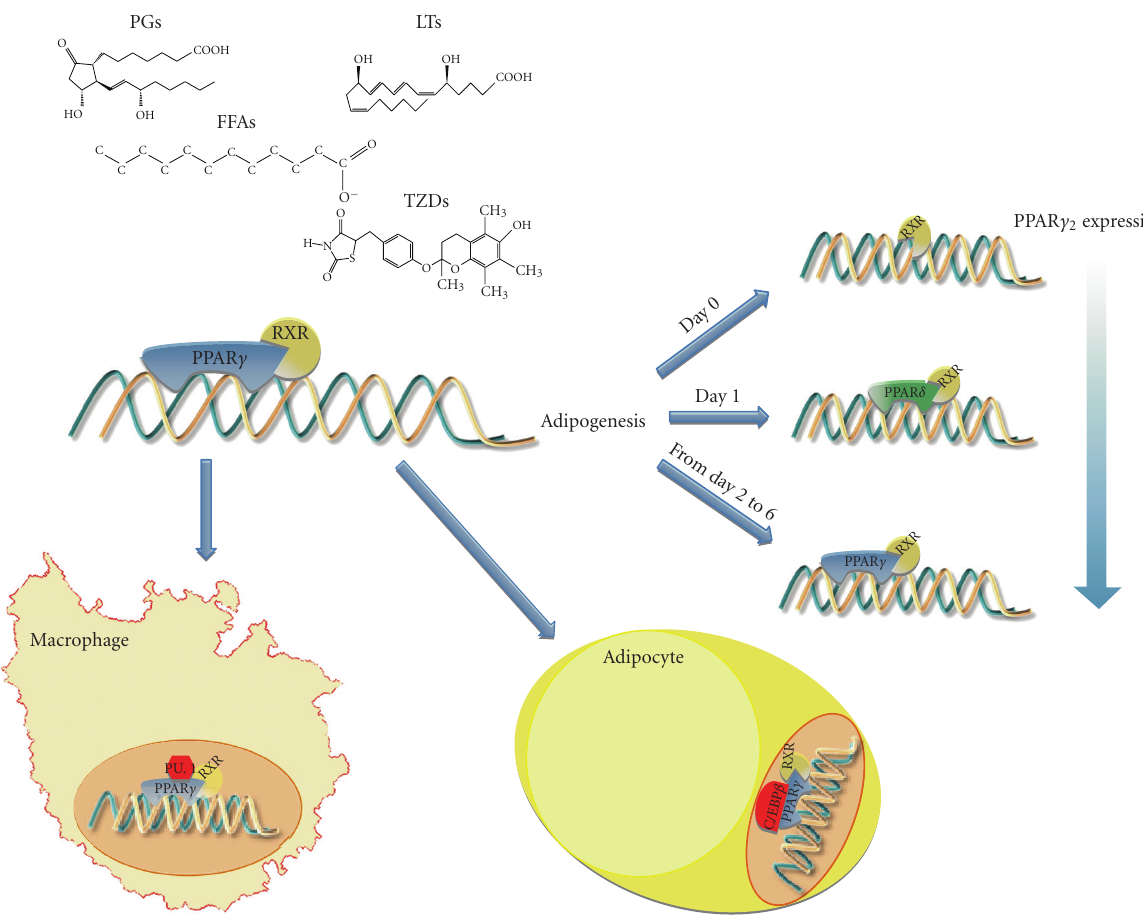
Figure 1: Novel insight into PPARG world trough new approaches. In the presence of ligands (upper), PPAR γ binds to its PPRE as heterodimer with RXR to activate or repress target genes’ expression. The figure summarizes novel molecular mechanisms of PPAR γ obtained through ChIP-seq. PPAR γ - and RXR-binding sites detected by ChIP-seq reveal di ff erent spatial and temporal activation of distinct metabolic pathways and changes in RXR dimer composition during adipogenesis (right panel, study from [28]). PPARγ in Adipocytes and Macrophages: tissue-specific regulatory regions employ cell-type-specific coregulators, C/EBP β in adipocytes and PU.1 in macrophages (lower panel; ChIP- Seq study from